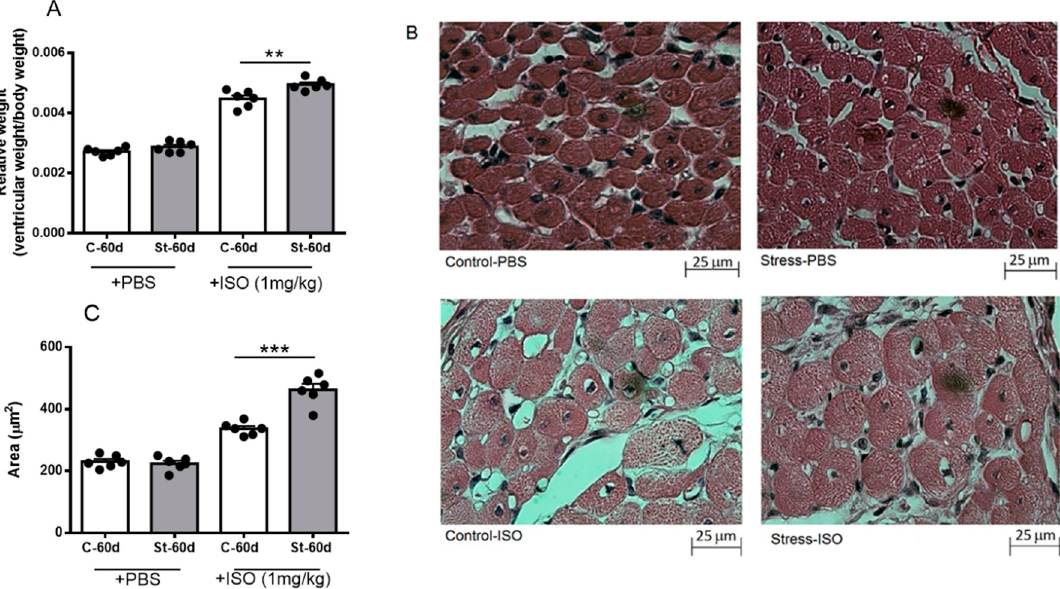
Figure 5. Relative weight ( A ), morphology ( B ), and area ( C ) of cardiomyocytes of 60-day-old male rats after 10 days of isoproterenol or PBS treatment. Hearts were collected at 60 days old after 10 days of treatment with a daily dose of 1 mg/kg of isoproterenol. The results are the mean value ± SEM of 6 animals in each group. The bar indicates the magnification of the picture. A: ** p < 0.01 control-ISO vs. stress-ISO; C: *** p < 0.001 control-ISO vs. stress-ISO.